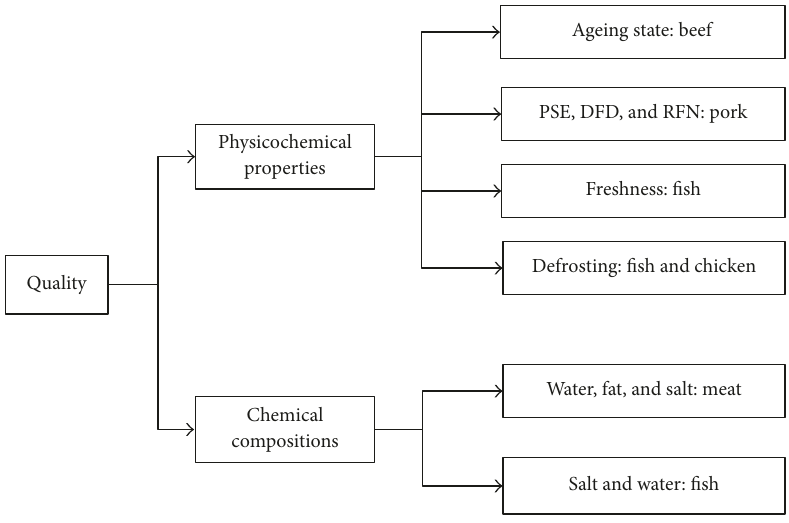
Figure 8: Framework of